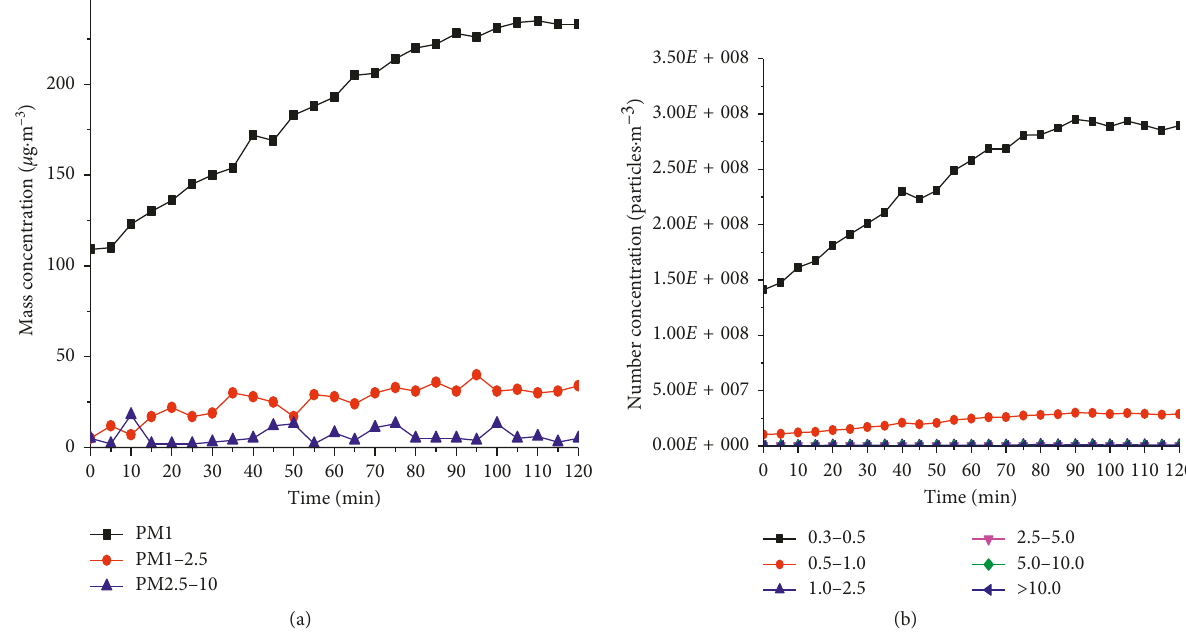
Figure 4: The indoor particle concentration in outdoor PM10 � 400–500 μ g · m − 3 : (a) mass concentration; (b) number